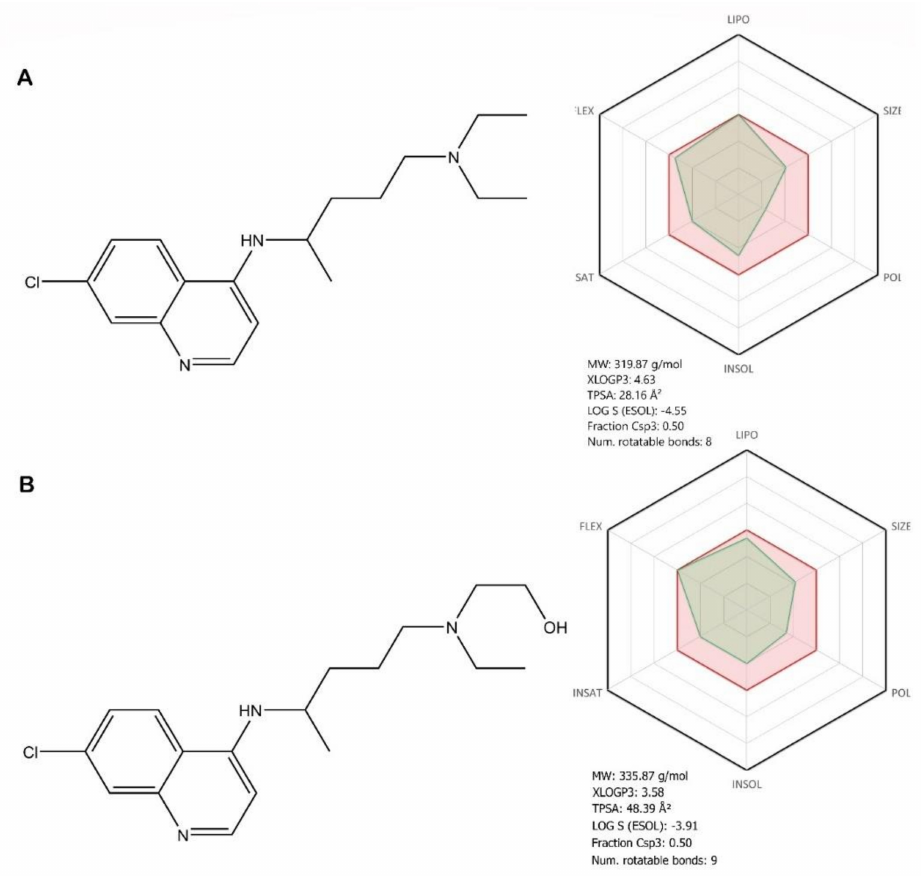
Figure 7. Chemical structure of chloroquine ( A ) and hydroxychloroquine ( B ) ADME profile was achieved using the free web tool SwissADME; the red highlighted area represents the suitable physicochemical space for oral bioavailability, covering value intervals for the following: LIPO (lipophility): − 0.7 < XLOGP3 < + 5.0, SIZE: 150 g / mol < MV < 500 g / mol, POLAR (polarity): 20Å 2 < TPSA < 130Å 2 , INSOLU (insolubility): 0 < Log S (ESOL) < 6, INSATU (insaturation): 0.25 < Fraction Csp3 < 1, FLEX (flexibility): 0 < Num. rotatable bonds < 9, whereas the overlapped green highlighted area shows the calculated ADME profile for the molecule